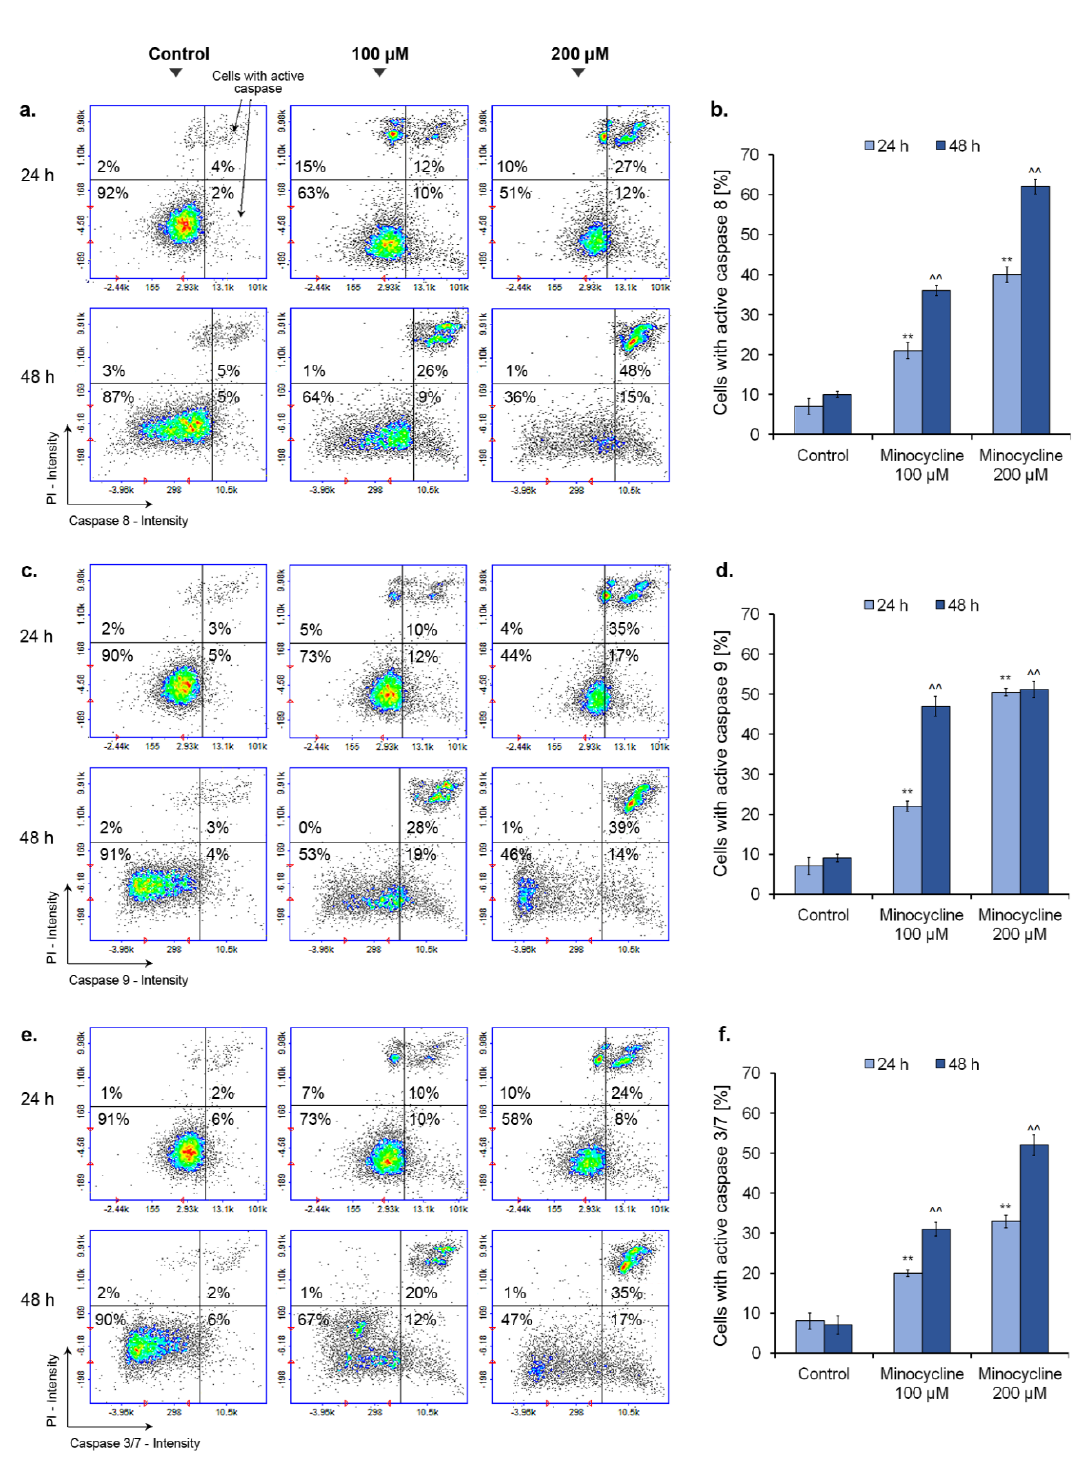
Figure 10. Minocycline activates caspases in human melanoma cells after 24 h and 48 h treatment. Presented scatter plots respond to representative results of the experiments for caspase 8 ( a ), caspase 9 ( c ), and caspase 3/7 ( e ). Mean values of the percentage of cells with activated caspases are presented in the bar graphs ( b , d , f ). ** p < 0.005 vs. control 24 h; ^^ p < 0.005 vs. control 48 h.